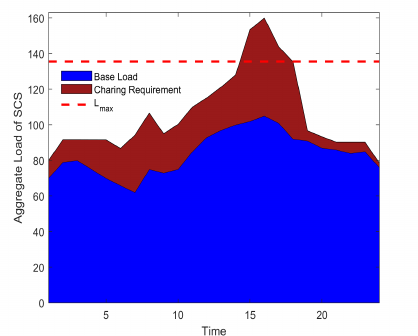
Figure 6. Charging strategies for 10 PEVs without overload control.